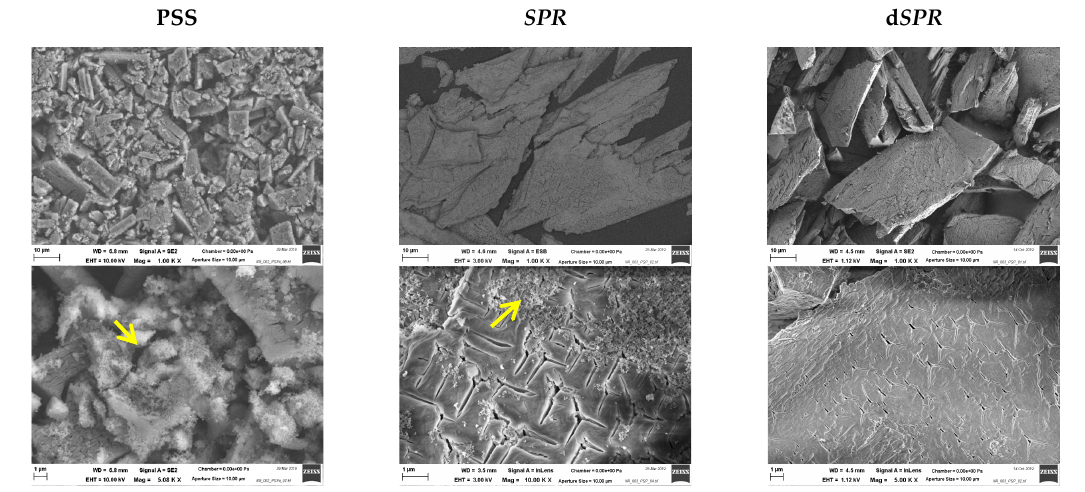
Figure 5. Scanning electron microscopy images of the precipitates that were obtained by mixing phosphate-rich leachate from the HTL solid phase with the HTL liquid phase (PSS and SPR) and by direct precipitation from the HTL liquid phase (d SPR) . Solid precipitates different from struvite are marked with a yellow arrow.